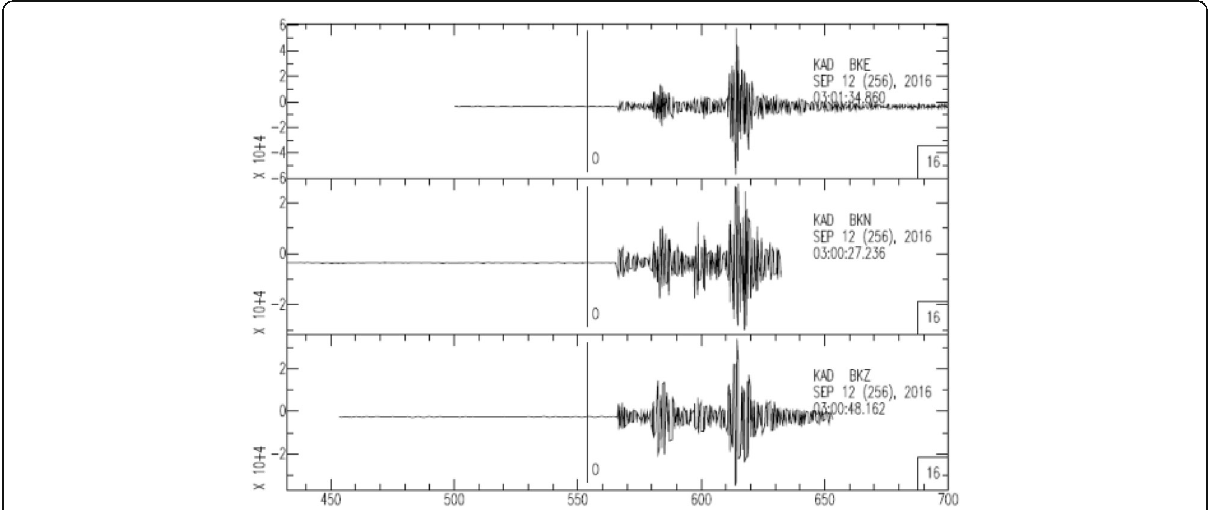
Fig. 13 Seismograms of the second and third tremor (Source: Centre for Geodesy and Geodynamics Toro)